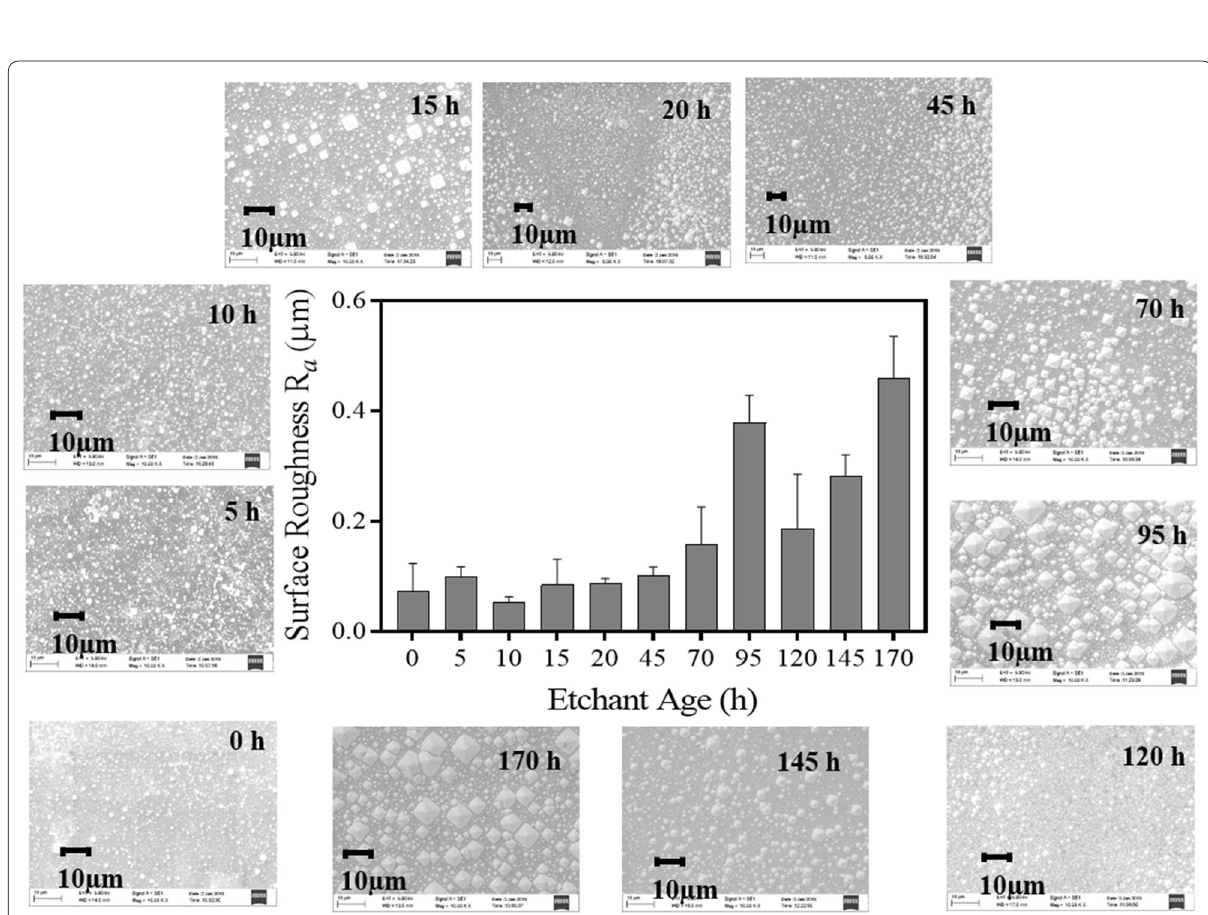
Fig. 45 Etched surface roughness (Ra) and corresponding surface morphologies of Si{100} etched in 10% NH 2 OH etchant age at 70 1 °C ±